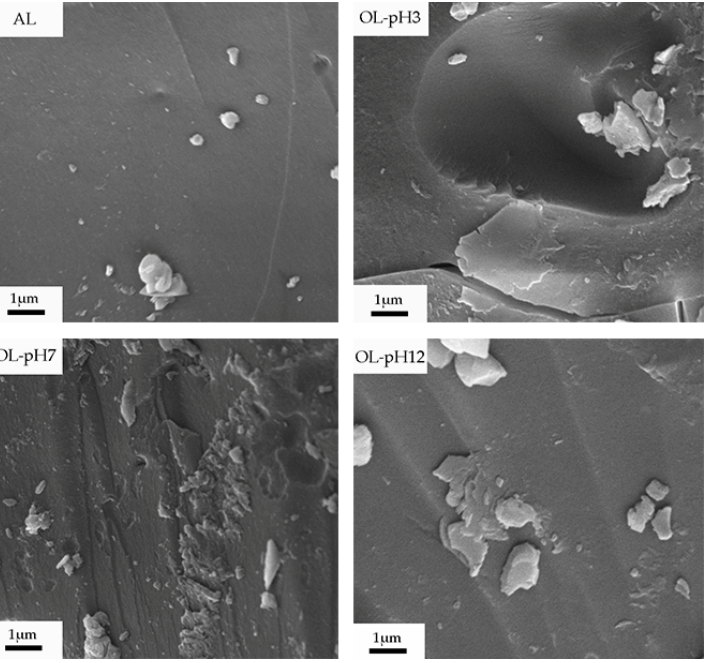
Figure 1. Scanning electron microscopy (SEM) images of alkali lignin before and after ozone pretreatments.